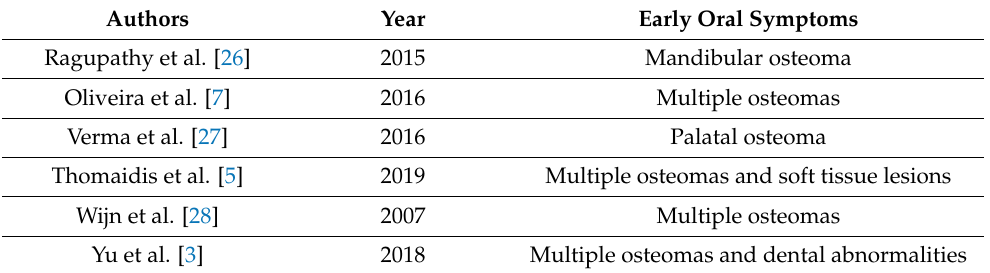
Table A1. Cont. Authors